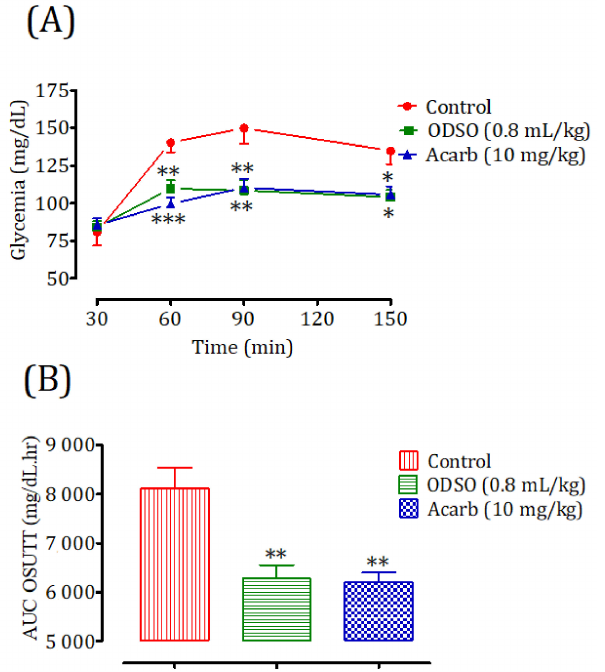
Figure 11. Effect of oil (ODSO) and acarbose (Acarb) on the change in the postprandial glycemia in normal rats ( A ), with a representation of the area under the curves ( B ). The values are the means ± SEM ( n = 6). * p < 0.05, ** p < 0.01, and *** p < 0.001 compared to the